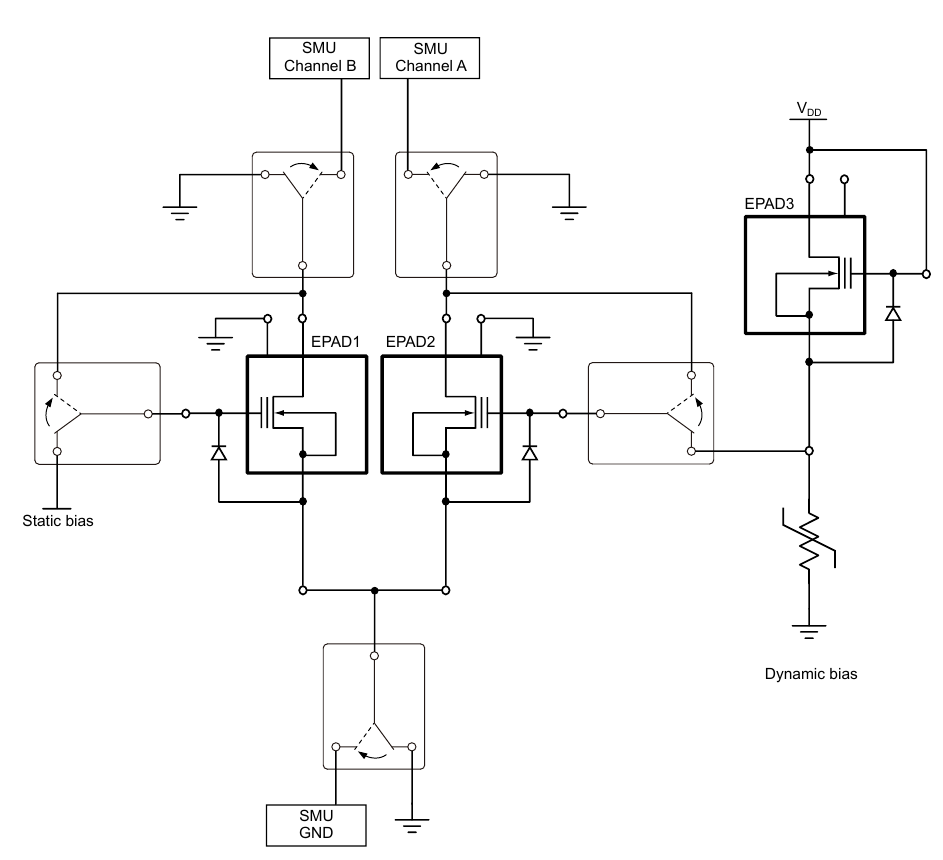
Figure 9. Electrical schematic of EPADs